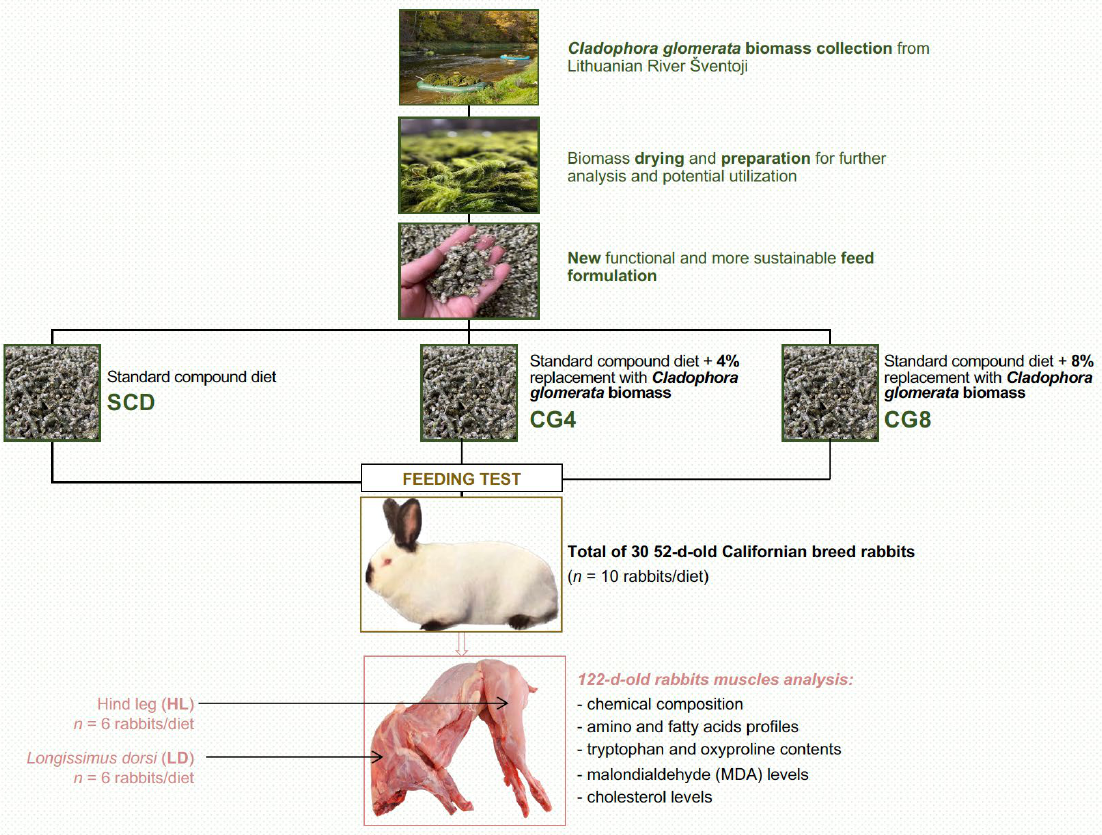
Figure 1. Protocol structure from the Šventoji River to rabbit muscle analysis.